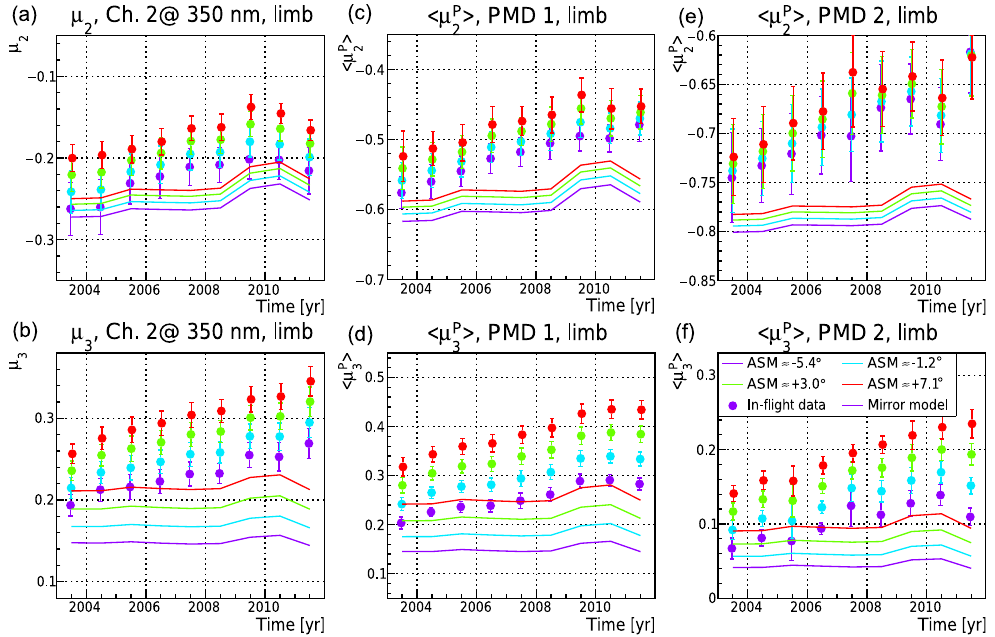
Figure 12. Time dependence of in-flight end-to-end Mueller matrix elements µ 2 (a, c, e) and µ 3 (b, d, f) for limb at TH ≈ 28km for four selected ASM angles from measurements (data points) and the scan mirror model (lines). The error bars include statistical and total systematic errors. (a, b) Channel 2 feature; (c, d) PMD 1; (e, f) PMD 2. The color code signifies the ASM scan angle bin ( − 5, − 1, + 3, + 7 ◦ ), increasing on a rainbow color